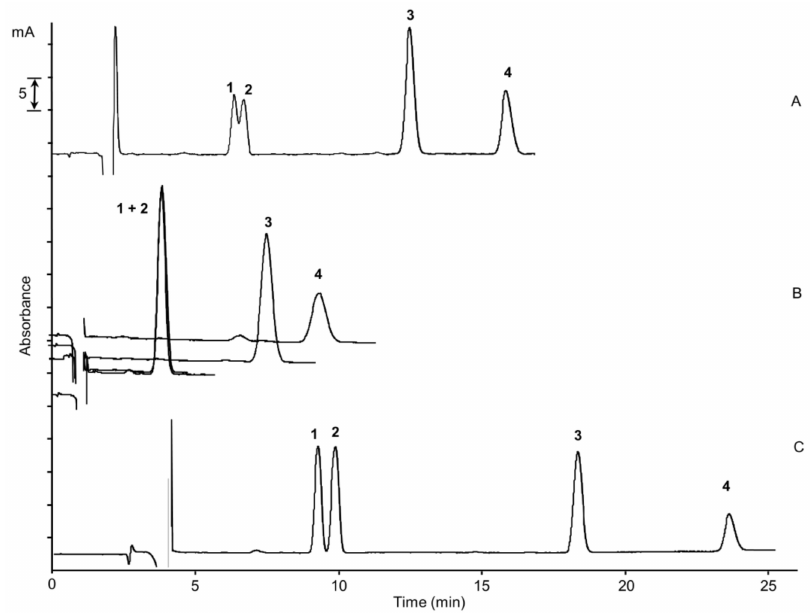
Figure 2. Nano-LC chromatograms of the separation of the four cannabinoids on different stationary phases: capillary columns (100 µ m × 25 cm) packed with ( A ) Cogent Bidentate C18 dp 4.2 µ m, ( B ) Gemini C18 dp 5 µ m, ( C ) ChromSpher C18 dp 3 µ m; mobile phase, acetonitrile/H 2 O/formic acid, 80/19/1% ( v / v / v ); UV detection, 214 nm; standard mixture concentration, cannabigerol (CBG) and cannabidiol (CBD) at the concentration of 15 µ g/mL, cannabichromene (CBC) and ∆ 9 - tetrahydrocannabinol ( ∆ 9 -THC) at a concentration of 30 µ g/mL; injection time, 15 s; flow rate, 550 nL/min. (1) CBG, (2) CBD, (3) ∆ 9 -THC, (4)